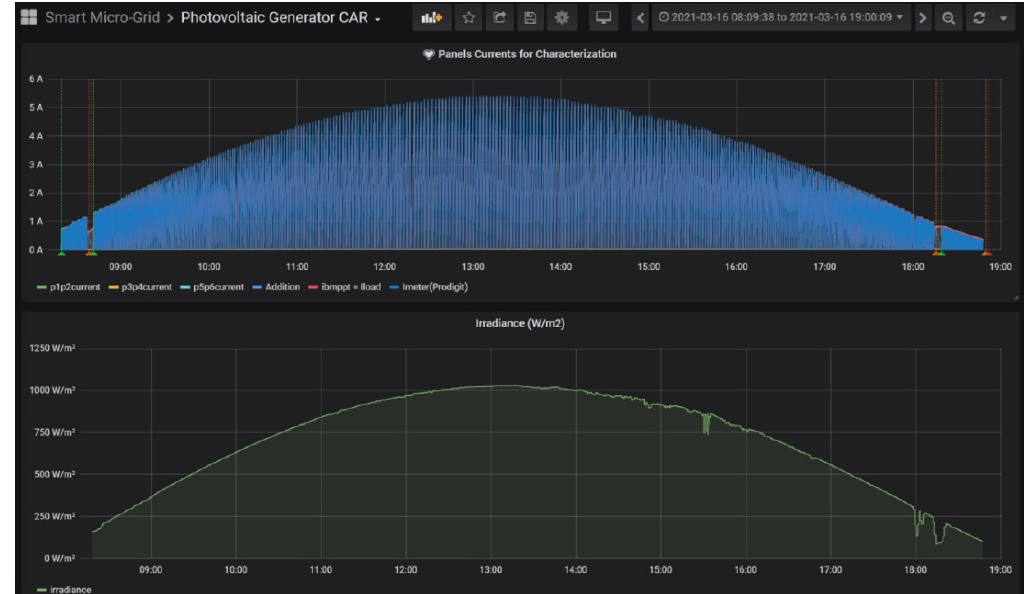
Figure 11. Grafana GUI displaying time ‐ series of PV current and irradiance during a day of characterization.